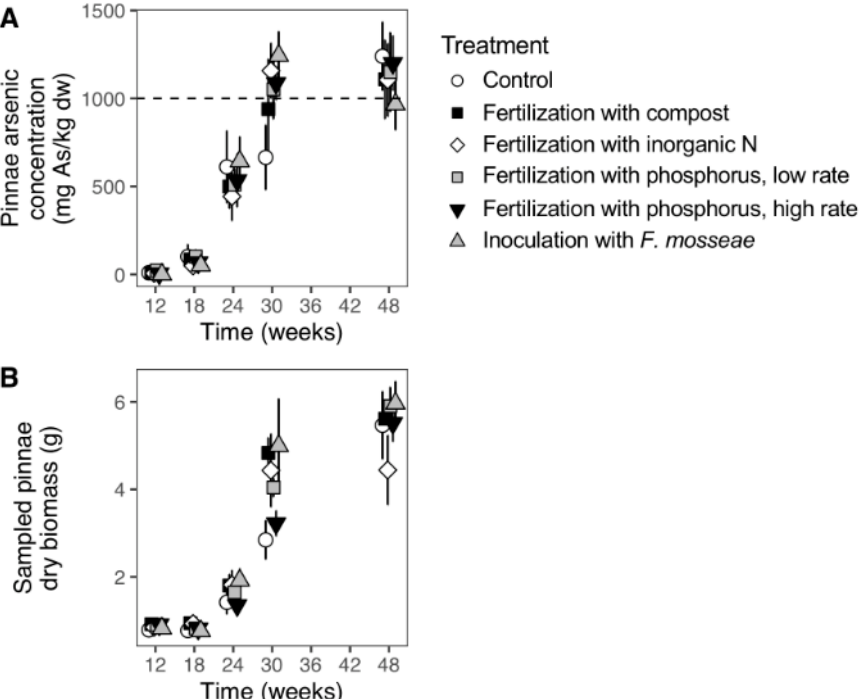
Figure 1. Temporal evolution of ( A ) mean dry sampled pinnae arsenic concentrations and ( B ) mean dry sampled pinnae biomass starting 12 weeks after fern transplant into arsenic-contaminated soils. Dotted line in panel A indicates hyperaccumulation threshold. Symbols represent mean values per treatment, and error bars represent standard error of the mean. n = 6 plots / treatment. Points are slightly shifted on the X axis for